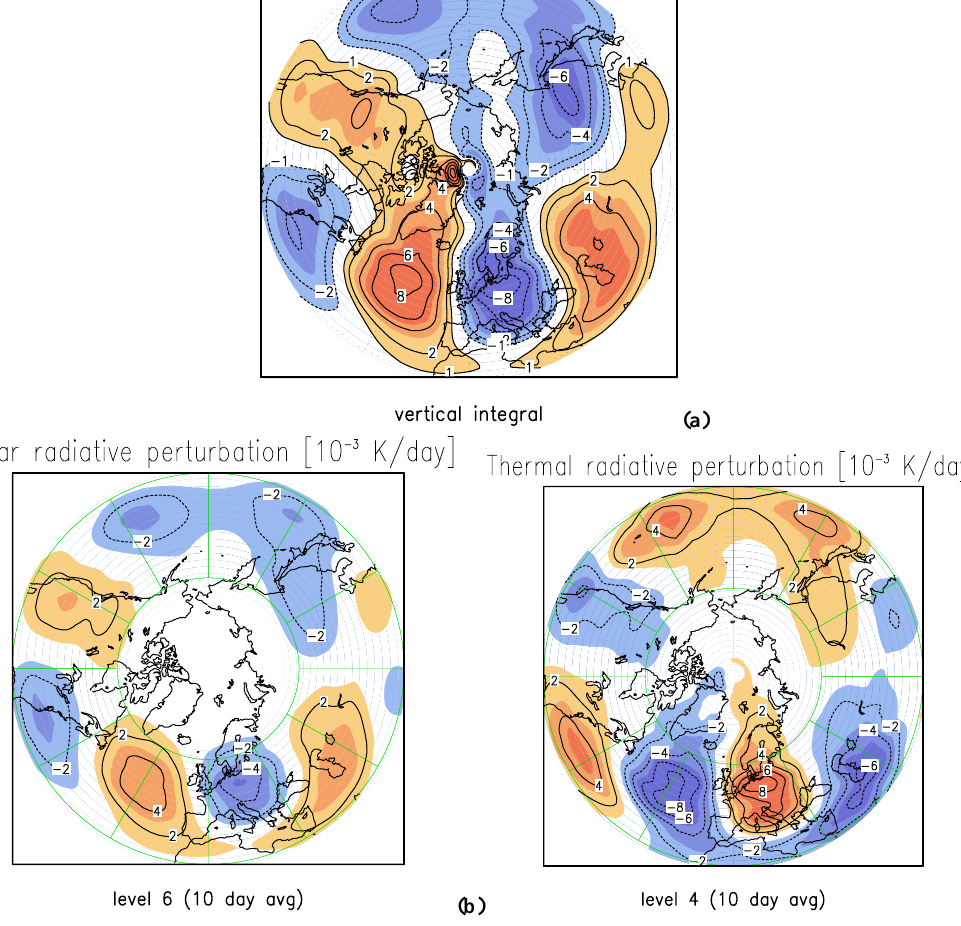
Fig. 1. Ozone anomaly and direct radiation forcing at 70 hPa Ozone anomaly and direct radiation forcing estimated under January conditions averaged over 10 days: (a) Vertically integrated ozone difference, (b) Solar radiation forcing due to the ozone difference at 150 hPa (model level 6), (c) Same as (b) but for the thermal radiation at 70 hPa (model level